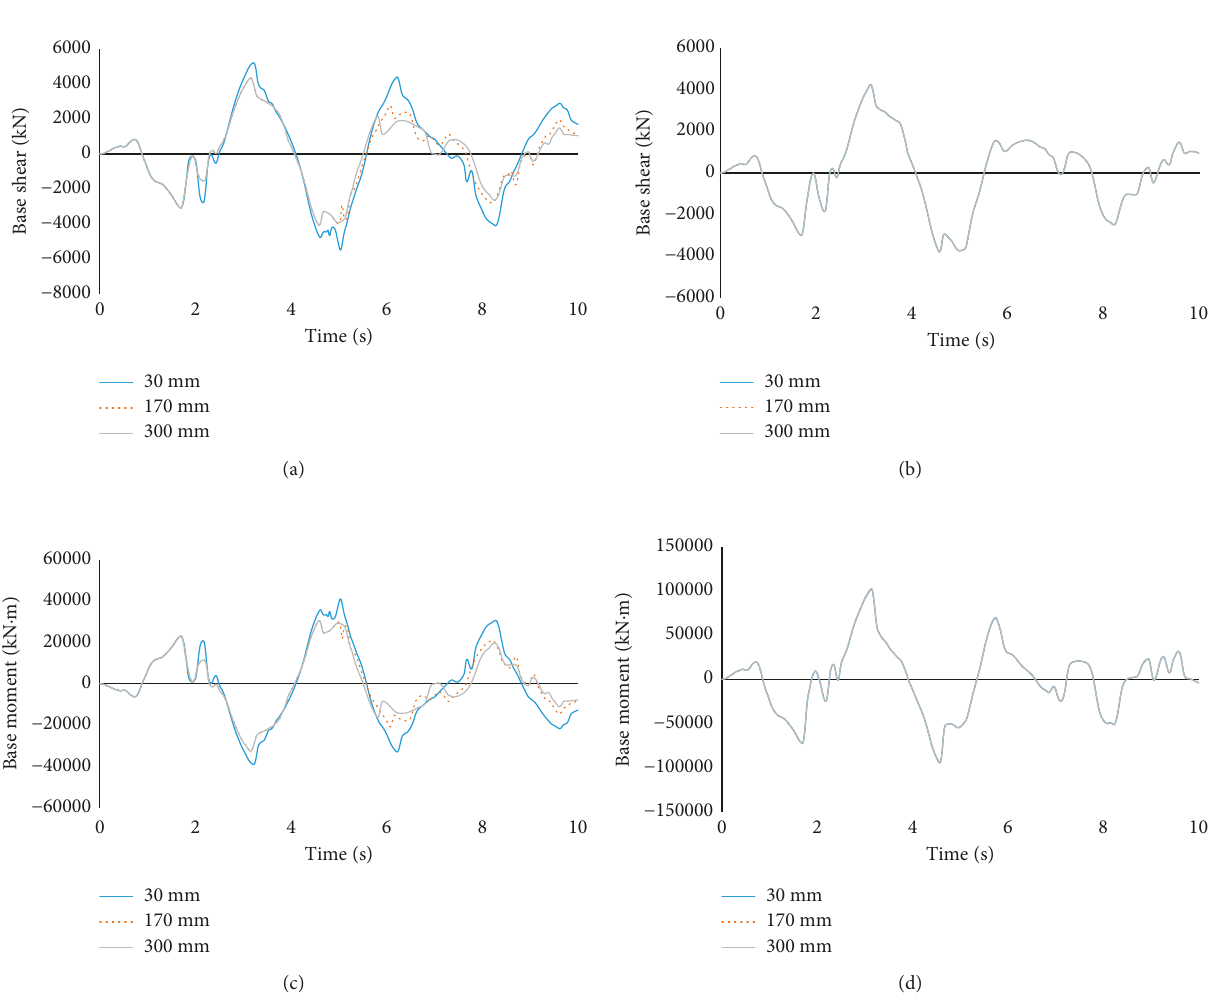
Figure 22: Effect of seismic gaps on base shear and base moment. (a) Longitudinal direction. (b) Transverse direction. (c) Longitudinal direction. (d) Transverse direction.